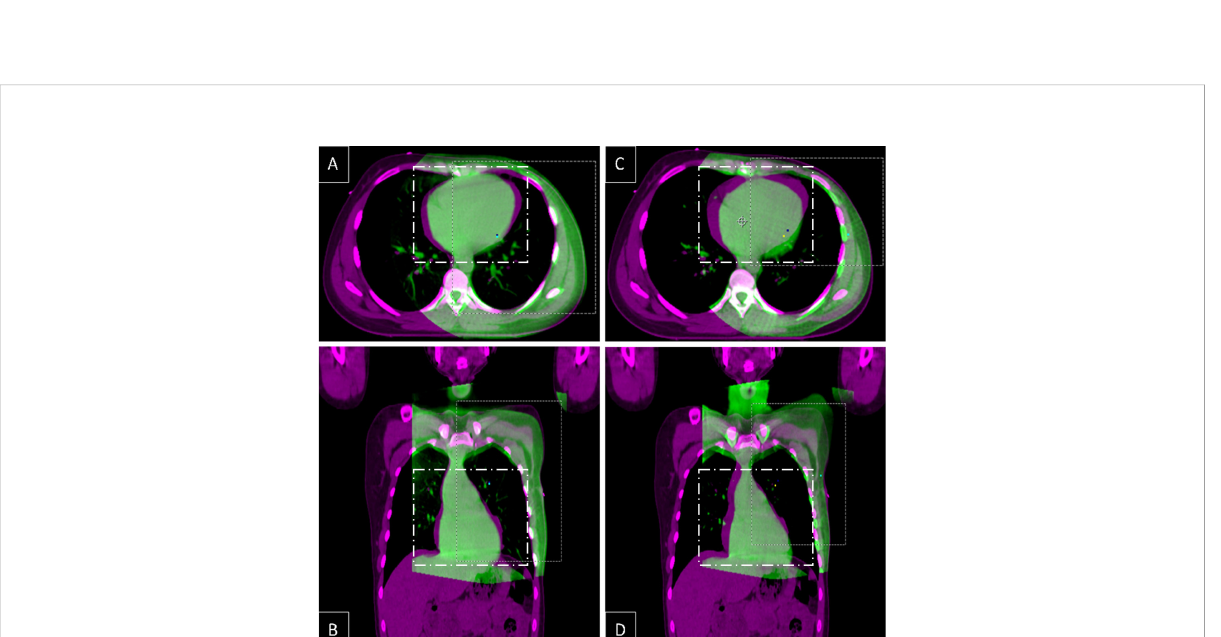
FIGURE 5 Fusion of axial (A, C) and coronal (B, D) CT slices from the same level in DIBH planning CT (pink) and the fi rst (A, B) and the last (C, D) CBCT (green), showing interfractional heart translation.